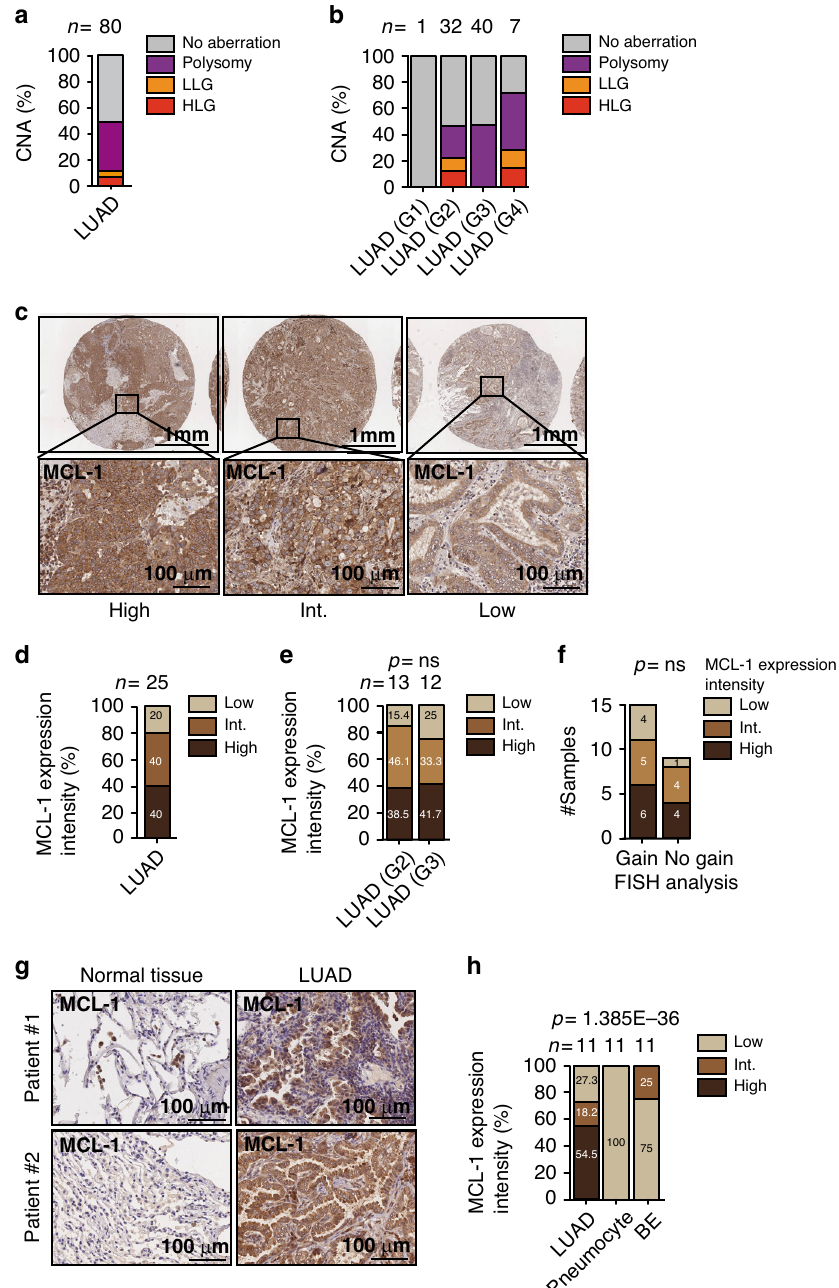
Fig. 3 MCL-1 is over-expressed in human LUAD. a , b Quanti fi cation of FISH analysis for MCL-1 in LUAD TMA in all the samples ( a ) or divided by grade ( b ). n = 80. HLG high-level gain, LLG low level gain. c , d Representative images ( c ) and quanti fi cation ( d ) of MCL-1 staining in TMA of LUAD ( n = 25). MCL-1 staining intensity was assessed and classi fi ed as low, intermediate (int.), or high. e Comparison of MCL-1 staining intensities between different histological grades of LUAD (G2, n = 13; G3, n = 12). Data were analysed with the Pearson ’ s chi-squared test with continuity correction (ns, p = 0.0930, chi-square(2) = 4.750). f Association between FISH and IHC analyses on TMA samples. A two-sided Fisher ’ s exact test was applied as statistical test (ns, p = 0.75). g – h Representative images ( g ) and quanti fi cation ( h ) of MCL-1 staining in LUAD and paired normal tissue ( n = 11). Data were analysed by Pearson ʼ s chi- squared rest with continuity correction ( p = 1.385E − 36, chi-square(4) = 174.1). Scale bar is 1 mm or 100 µ m. BE bronchial